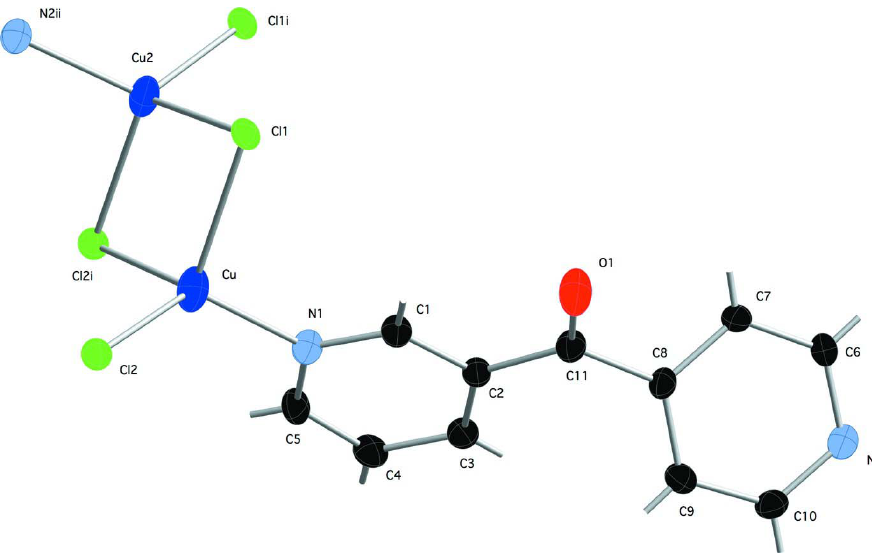
Figure 1 Asymmetric unit of (I), expanded to show the metal coordination spheres, showing 50% probability ellipsoids. Hydrogen atom positions are shown as gray sticks. Symmetry codes: (1) x - 1, y , z (ii) - x , y - 1/2, - z + 1/2